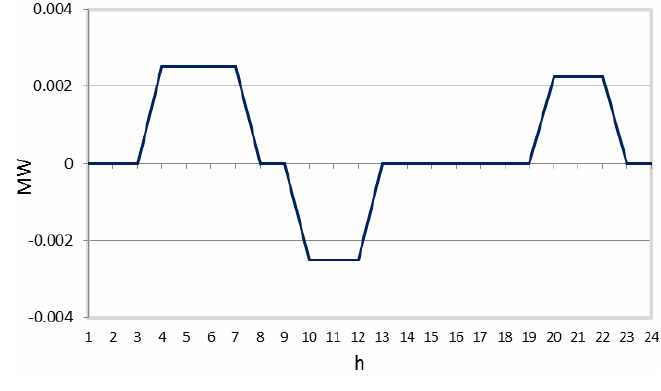
Figure 7. Power supplied from the battery along the first 24 h of the scheduling horizon.